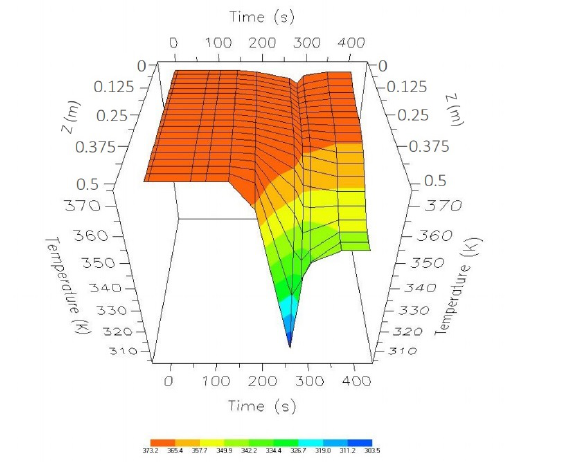
Figure 22. Comparison of the optimal results with the nominal values from the start-up to the